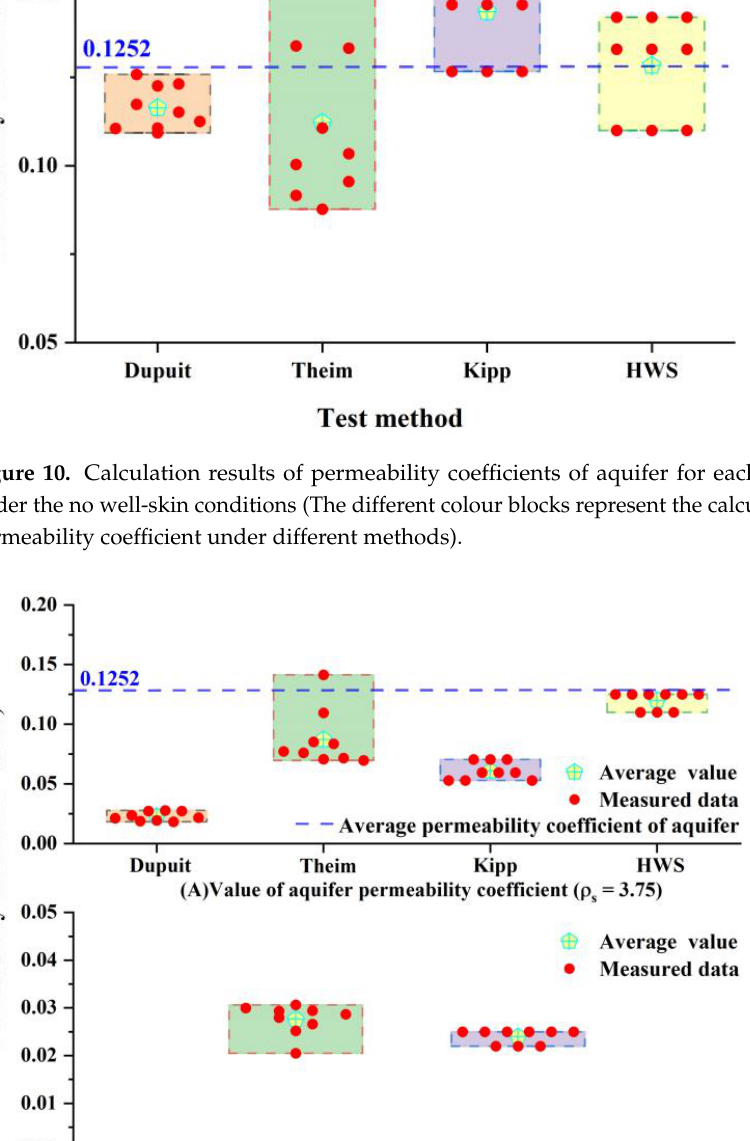
Figure 11. Calculation results of permeability coefficients of aquifer and well-skin layers for each